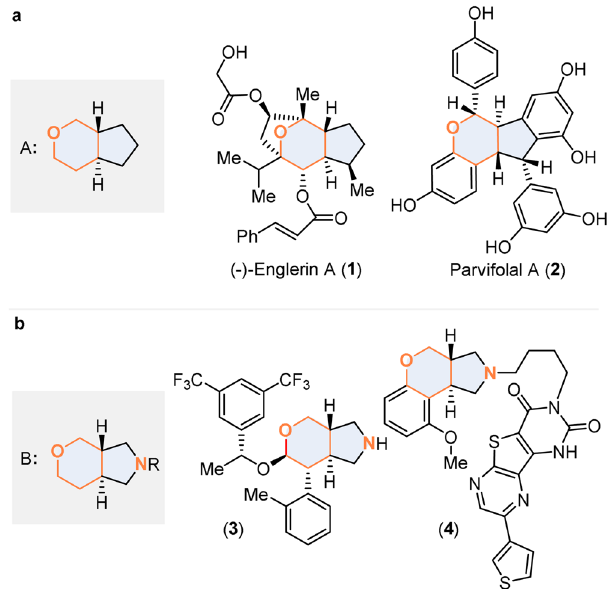
Fig. 1 Bioactive molecules containing a trans-fused tetrahydropyran bicyclic motif. a Selected bioactive natural products with a trans -fused tetrahydropyranocyclopentane motif. b Selected synthetic bioactive molecules with a trans -fused octahydropyranopyrrole motif.